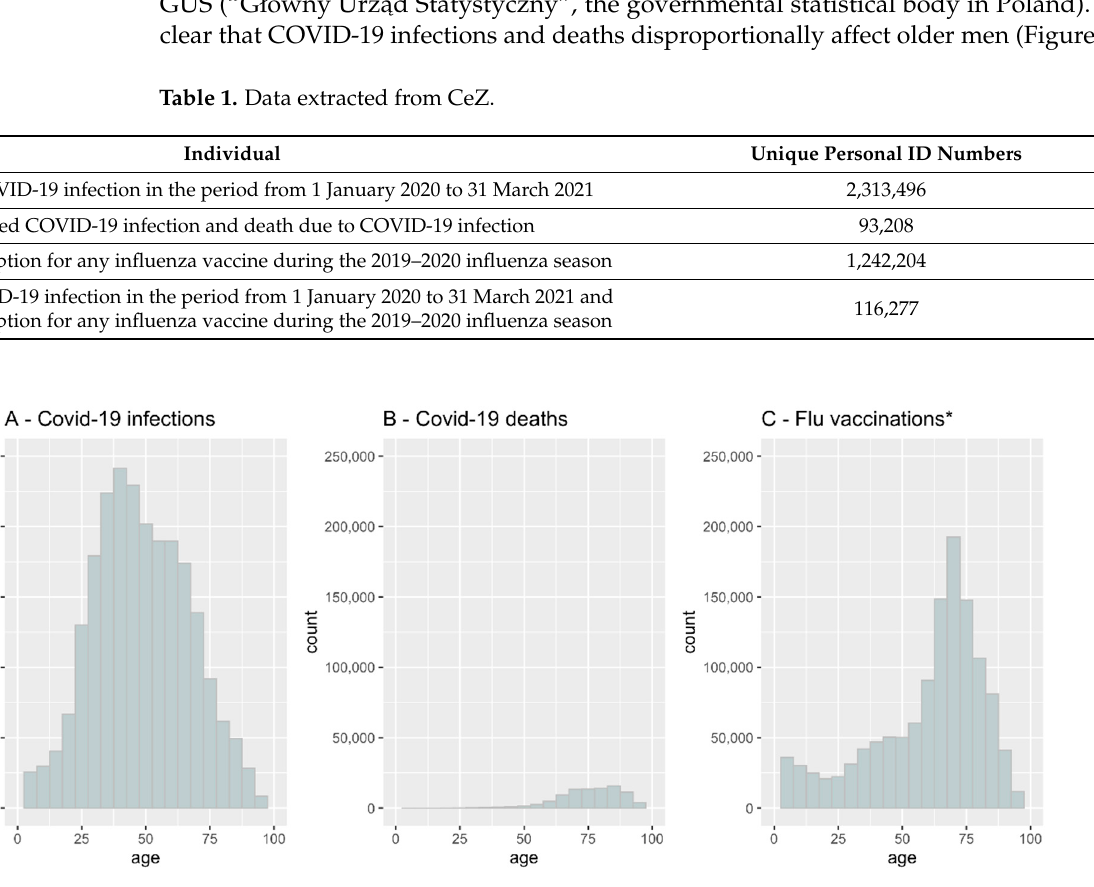
Table 1. Data extracted from CeZ.